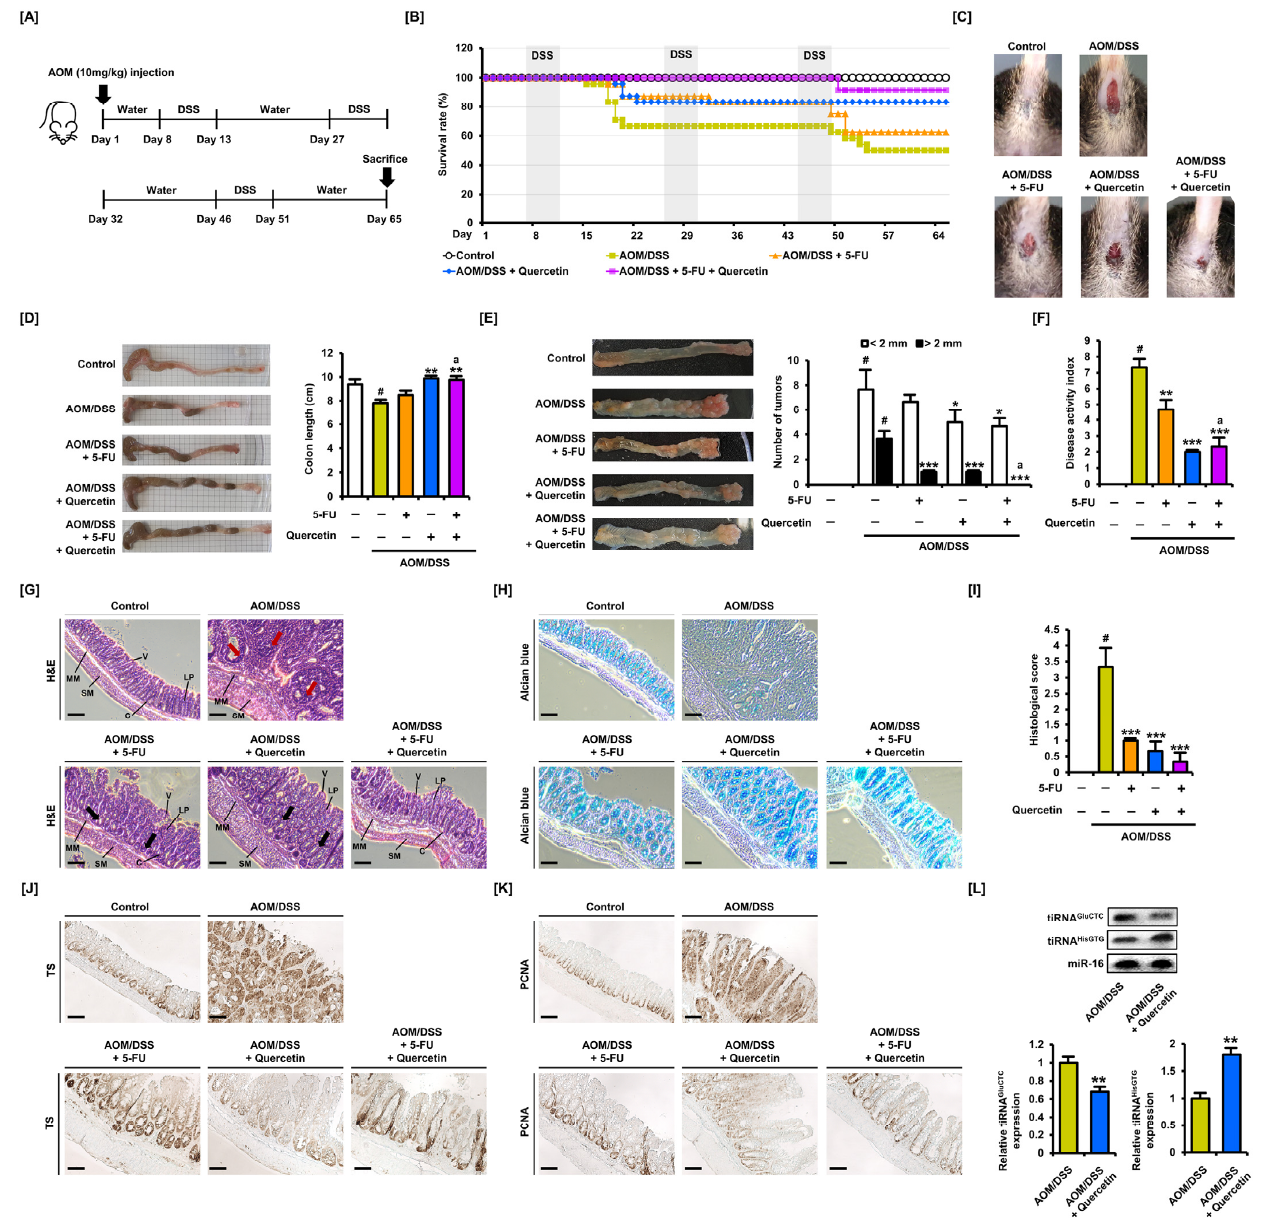
Figure 7. The inhibitory effect of quercetin on tumor growth was investigated in the colitis-associated CRC mouse model. ( A ) Schematic diagram of colitis-associated CRC mouse model established through AOM injection and oral supply of DSS. ( B – D ) Changes in survival rate ( B ), rectal bleeding ( C ), and colon length ( D ), according to administration of 5-FU and quercetin in CRC mice. ( E ) The number of tumors was counted according to the size of the tumor, based on the length of the long axis. ( F ) The disease activity index of CRC mice was quantified based on body weight loss, rectal bleeding, and stool consistency. ( G ) Hematoxylin and eosin (H&E) staining was performed to stain the nucleus and cytoplasm of distal colon tissues of CRC mice. V, villi; C, intestinal crypts; LP, lam- ina propria; MM, muscularis mucosae; SM, submucosa. Red arrows indicate tumor foci and black arrows indicate hyperplasia. ( H ) Alcian blue staining was performed to visualize goblet cells on distal colon tissues of CRC mice. ( I ) Histological scoring based on damage to crypts and goblet cells showed the effect of 5-FU and quercetin on intestinal damage. Histological scoring based on damage to crypts and goblet cells was performed to show the effect of 5-FU and quercetin on intestinal dam- age. ( J ) Immunohistological analysis was performed to visualize TS expression levels and localiza- tion in distal colon tissues of CRC mice. ( K ) Immunohistological analysis was performed to visualize